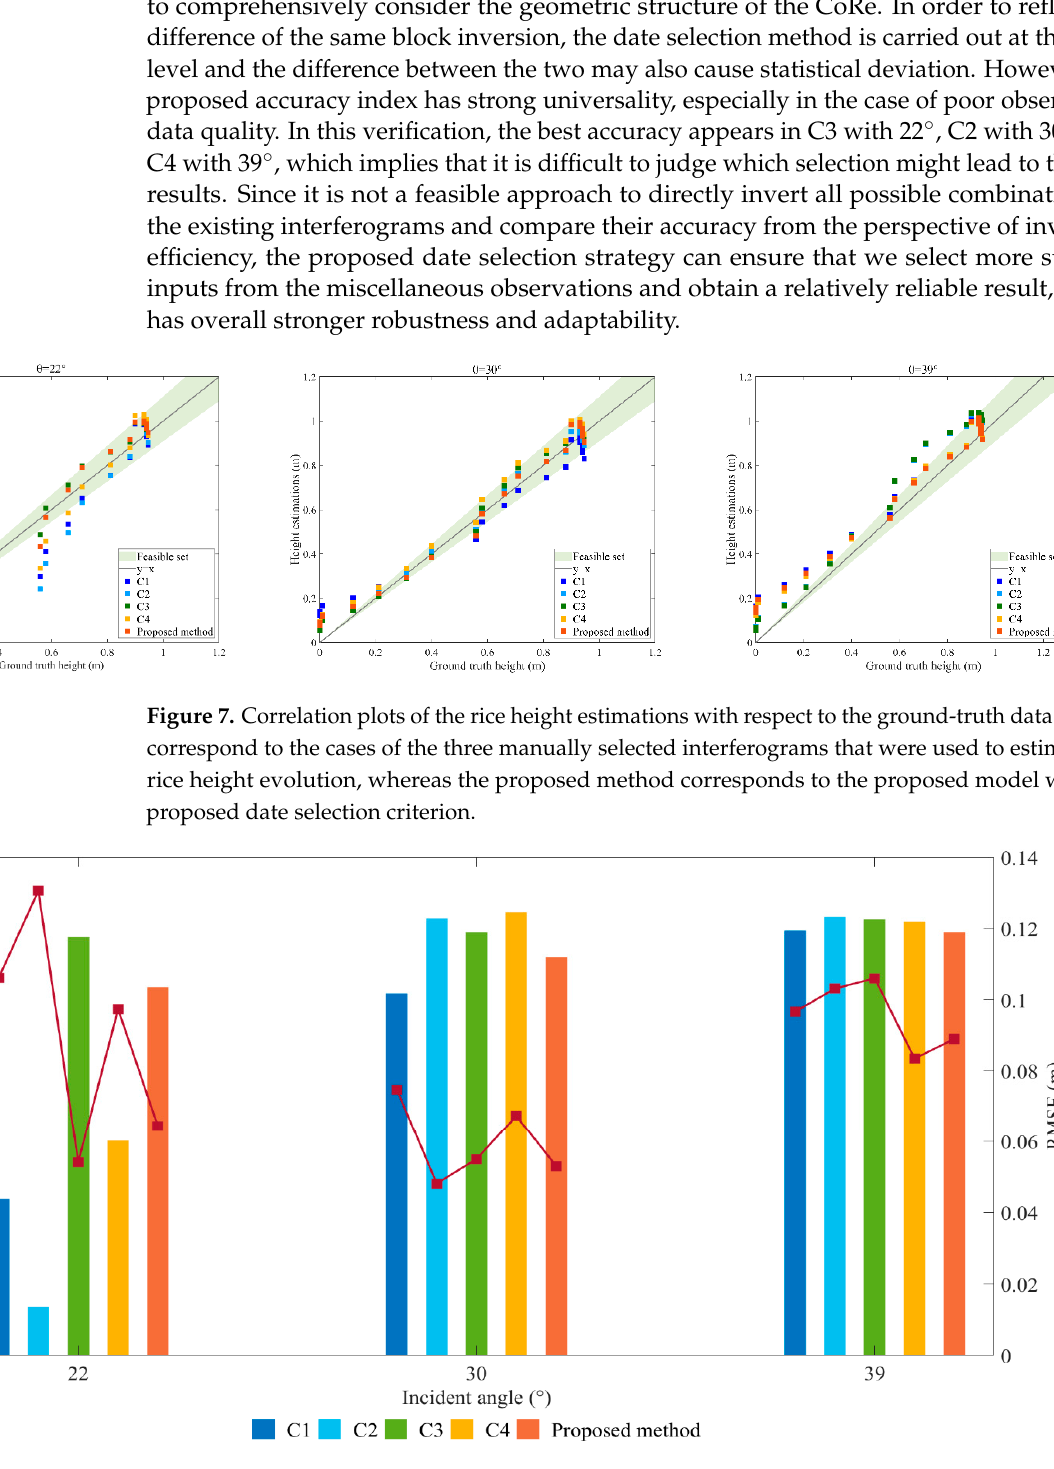
Figure 8. R² (bars) and RMSE (squares) of the rice crop height estimated with different combinations of inputs.